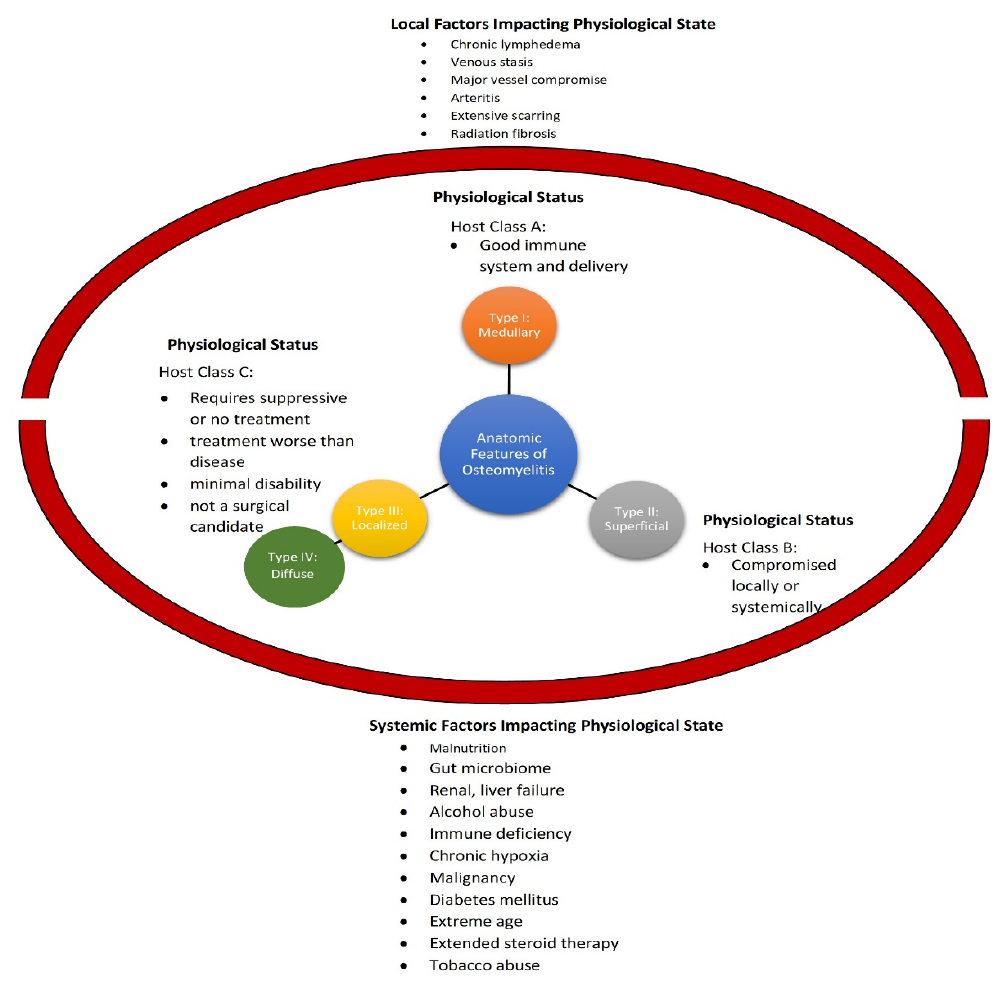
Figure 3. The Cierny and Mader classification reproduced [29]. Table 2. Lautenbach staging scale to integrate clinical, laboratory, and radiological findings. Table 2. Marais staging scale to integrate clinical, laboratory, and radiological